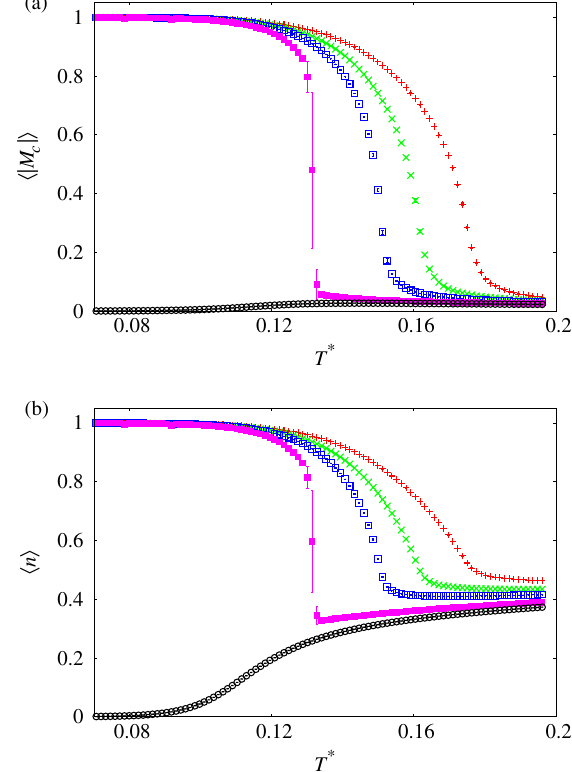
FIG. 2. (a) Order parameter M c for monopole crystallization, as defined in Eq. (4), and (b) density of charges n , as a function of reduced temperature T (cid:4) for chemical potential (cid:2) (cid:4) ¼ 0 : 767 (+), 0.778 ( (cid:6) ), 0.784 ( h ), 0.794 ( j ), and 0.801 ( (cid:7) ). The transition appears to pass from second order to first order via a tricritical point for (cid:2) (cid:4) tr (cid:5) 0 : 78 . The very narrow first-order region ends at (cid:2) (cid:4) (cid:5) 0 : 80 , above which spin-ice physics is recovered (e.g., the open black circles). The alternating positive or negative charges on the diamond lattice can also be seen as stacked monolayers of monopoles of the same charge in all three cubic directions. Note that the configurational constraints of the singly charged monopole fluid result in a high-temperature limit for the density of n ¼ 4 = 7 , rather than the n ¼ 0 : 5 expected for an unconstrained bipartite lattice gas. A generalization of the worm algorithm has been developed to ensure equilibration at low temperature (Appendix